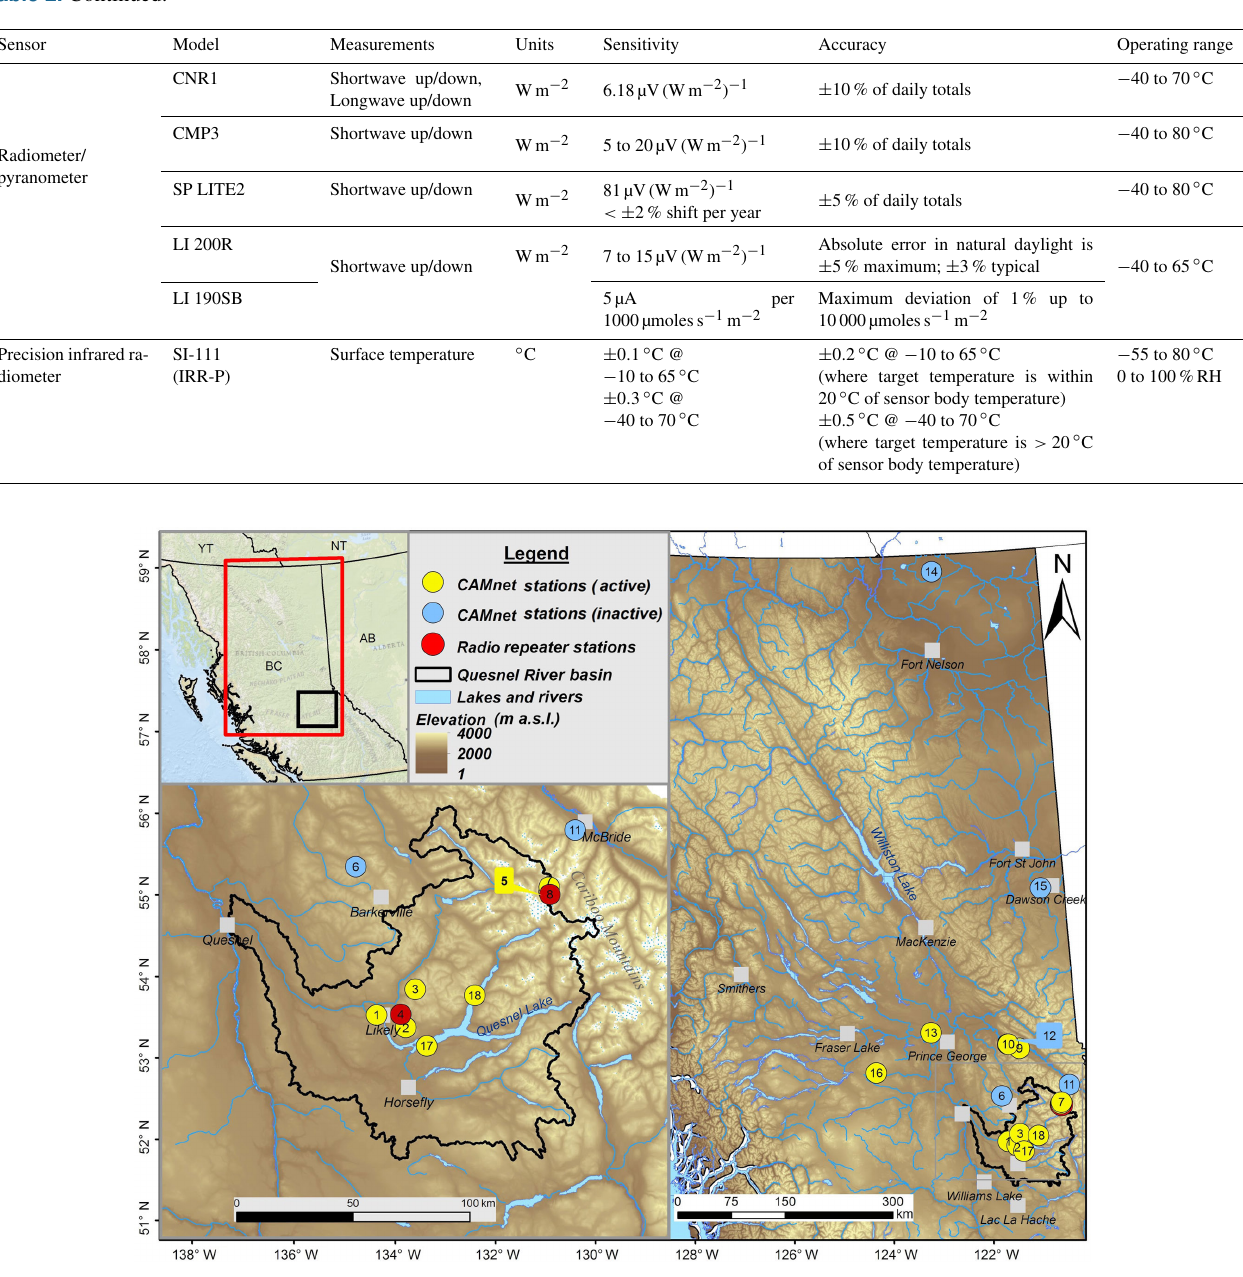
Figure 3. Map of north-central BC showing the location of active and inactive CAMnet weather and radio repeater stations, numbered as in